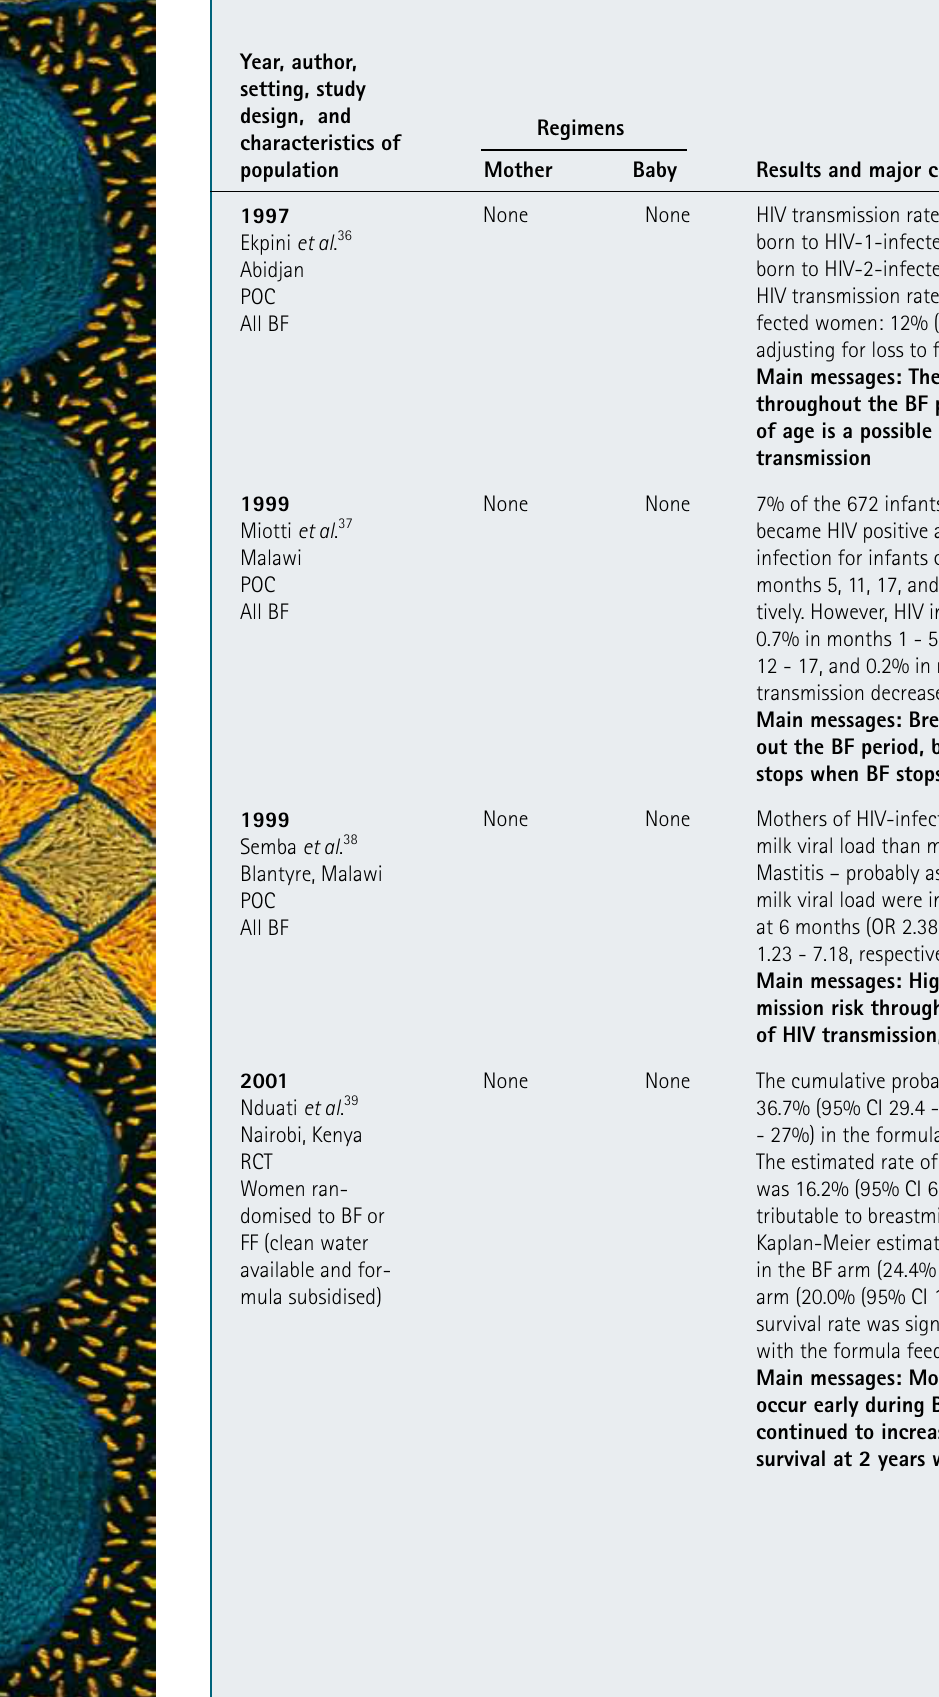
TABLE I. KEY STUDIES THAT HAVE CONTRIBUTED TO THE BODY OF KNOWLEDGE ON HIV AND INFANT